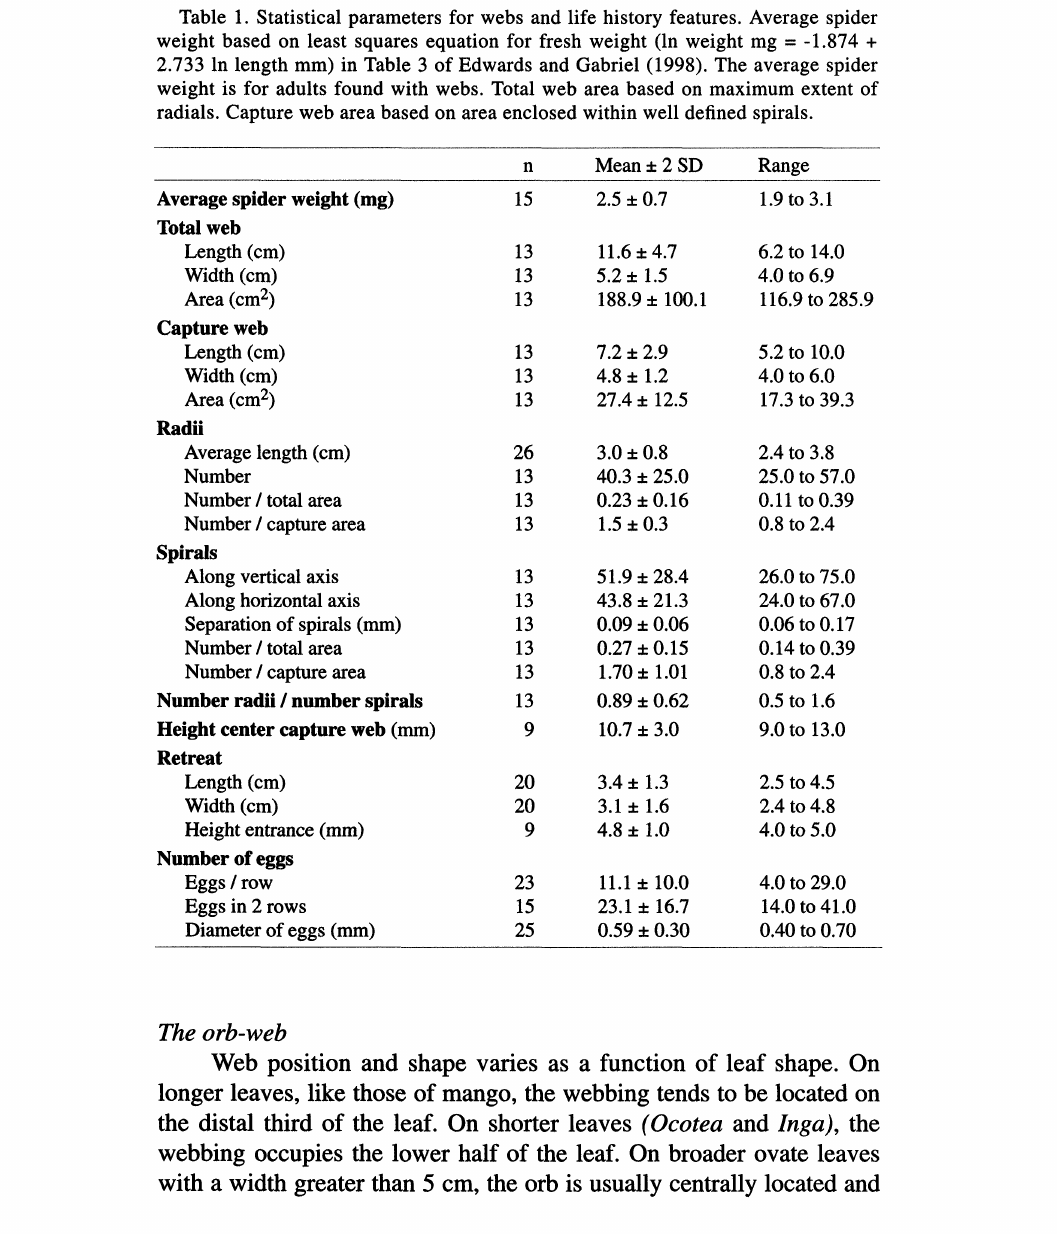
Table 1. Statistical parameters for webs and life history features. Average spider weight based on least squares equation for fresh weight (In weight